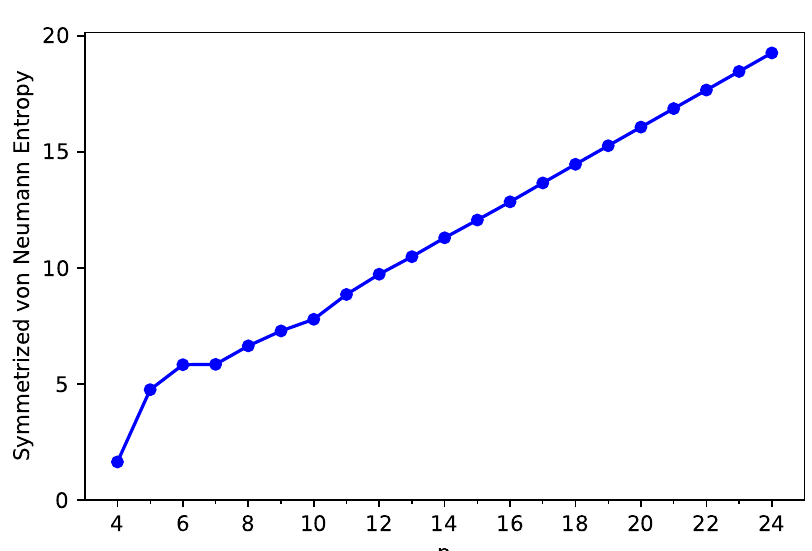
Figure 6. Symmetrized von Neumann entropy of ground-state C-Belt[ n ], computed using spin- unrestricted